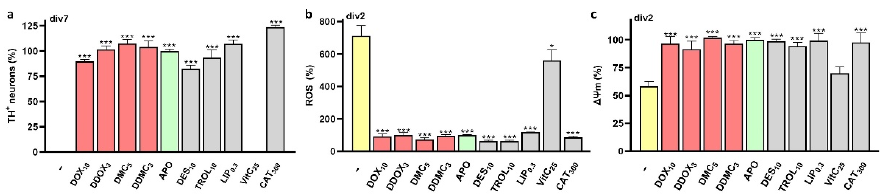
Figure 8. DOX , DDOX , DMC, and DDMC protect DA neurons by inhibiting oxidative insults elicited through a Fenton-type reaction. ( a ) Survival of TH + neurons in div7 midbrain cultures chronically exposed or not exposed to DOX (10 µ M), DDOX (3 µ M), DMC (5 µ M), DDMC (3 µ M), the iron chelator desferrioxamine (DES; 10 µ M), the inhibitor of lipid peroxidation TROL (10 µ M), the inhibitor of ferroptosis LIP (0.3 µ M), the H 2 O 2 detoxifying enzyme CAT (300 UI/mL), the water- soluble vitamin VitC (25 µ M), and APO (100 µ g/mL). Data expressed in % of APO-treated cultures are means ± SEM (3–18). *** p < 0.001 vs. NT. One-way ANOVA followed by Dunnett’s test. ( b ) ROS production monitored with the fluorogenic probe DHR-123 in div2 midbrain neurons exposed